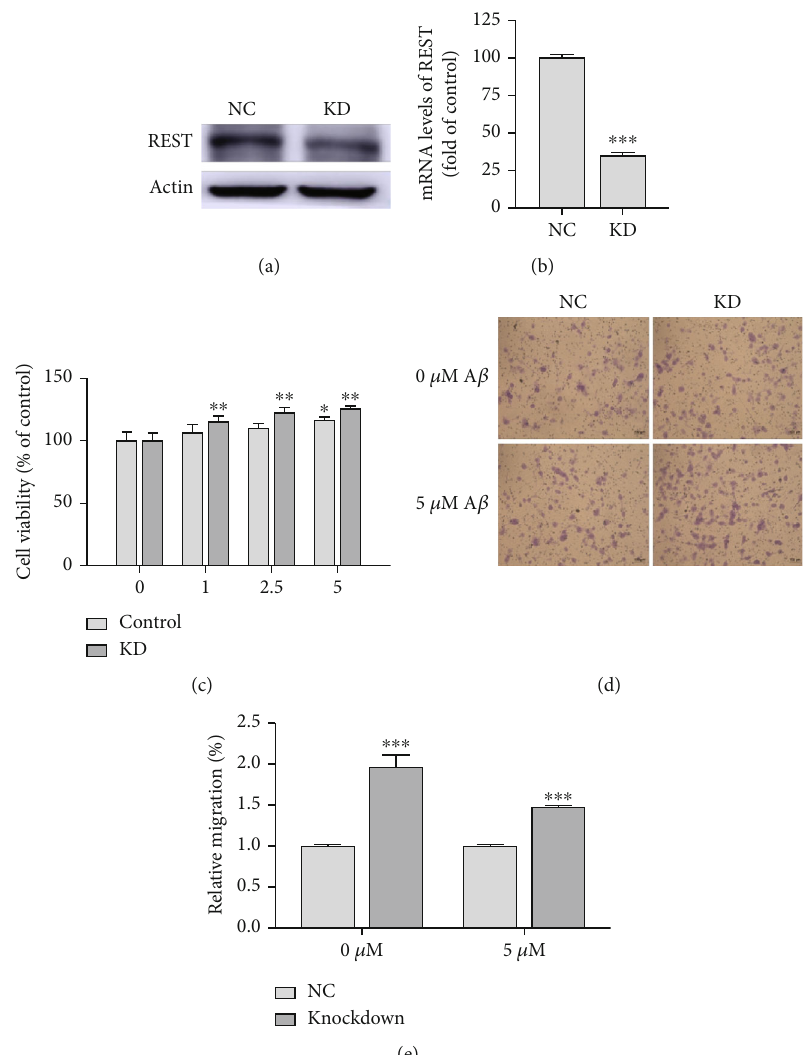
Figure 3: Knockdown of REST by short hairpin RNA increased A β -induced BV-2 cell proliferation and migration. (a, b) REST gene was 1-42 knocked down by short hairpin RNA about 75% at the mRNA level and 50% at the protein level. (c) Knockdown REST gene by short hairpin RNA promoted A β -induced cell proliferation. (d, e) When PC12 cells were inoculated in the lower chamber of the transwell system, 1-42 knockdown REST gene promotes BV-2 cell migration in the upper chamber no matter if PC12 cells were treated with A β or not. ∗ P < 1-42 0 : 05 vs. control, ∗∗ P < 0 : 01 vs. control, and ∗∗∗ P < 0 : 001 vs.